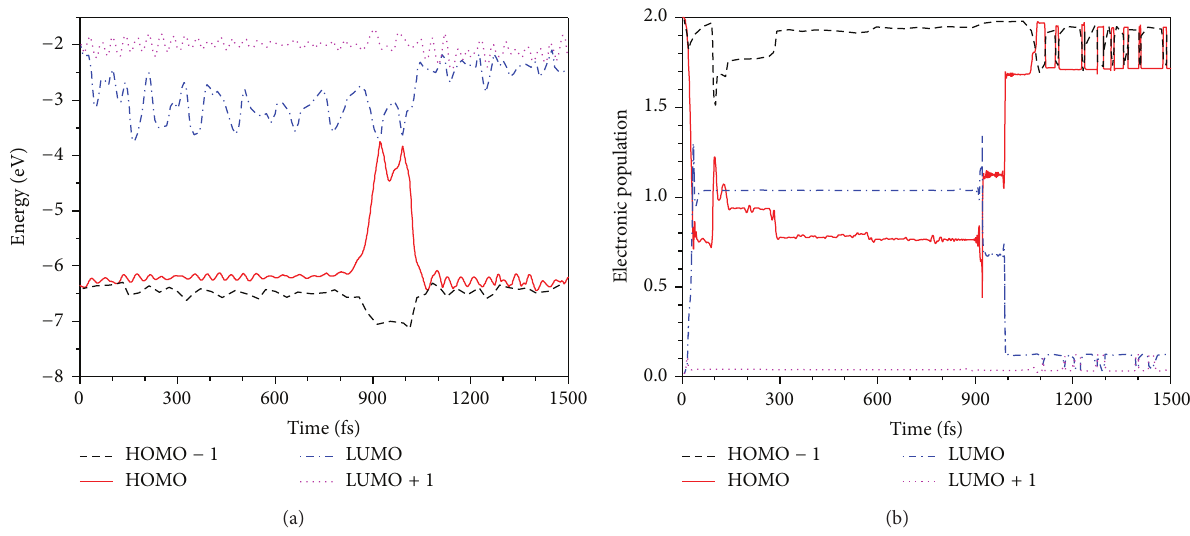
Figure 4: (a) The variations with time, (b) the time-dependent populations of the HOMO-1, HOMO LUMO, and LUMO + 1 energies of two stacked cytosine molecules.